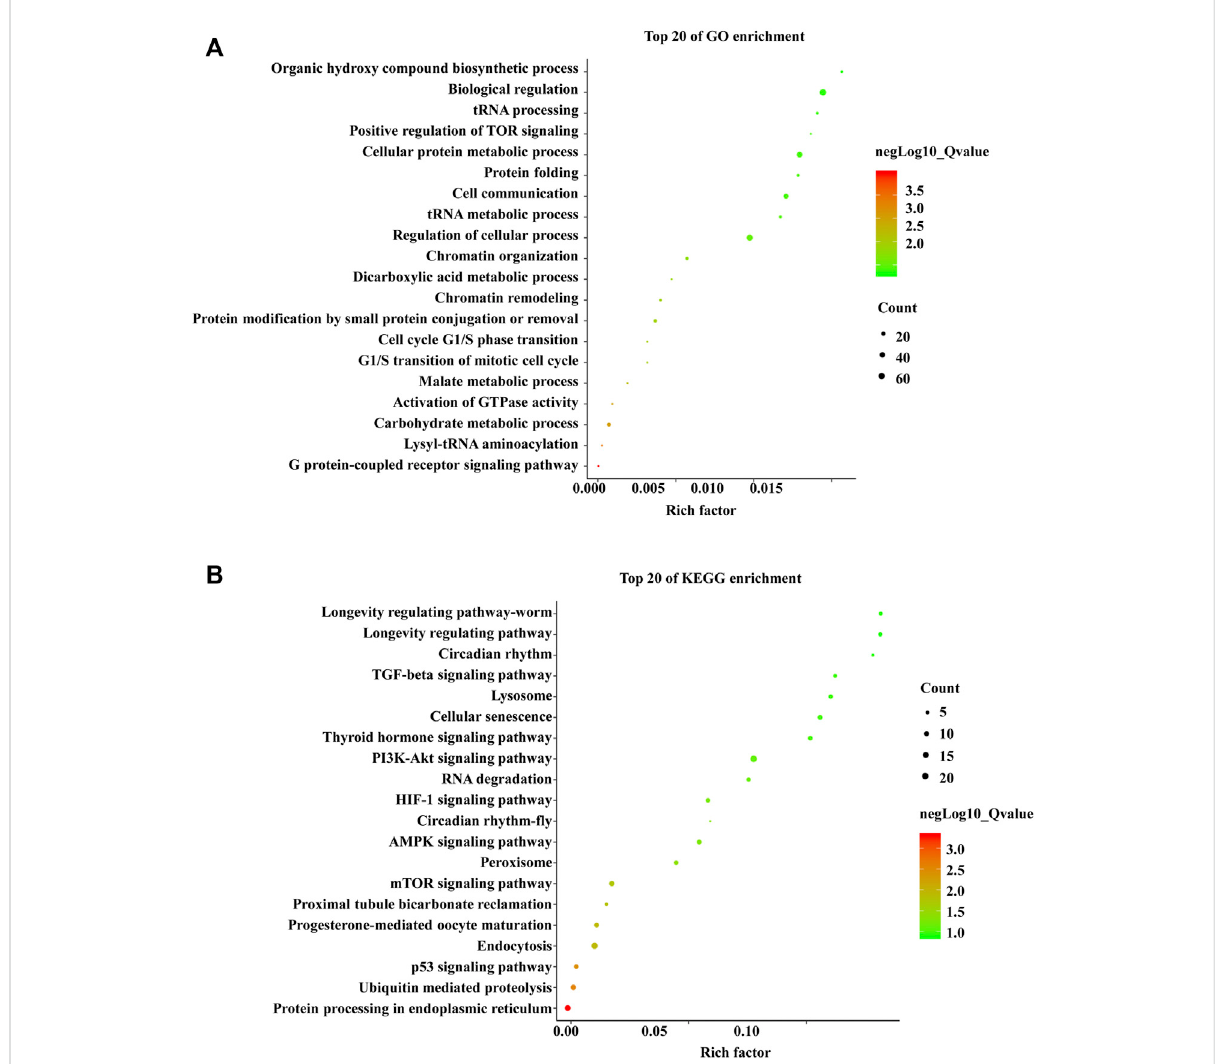
FIGURE 4 Gene Ontology (GO) and Kyoto Encyclopedia of Genes and Genomes (KEGG) enrichment analyses of the DE-miRNAs in the gonads of Collichthyslucidus . (A) GOenrichmentanalysisoftheDE-mRNAstargetedbyDE-miRNAs.The Y -axisrepresentsGOtermsandthe X -axisrepresents therichfactor.ThedotsizerepresentsthenumberofDE-mRNAsenrichedintheGOterms,andthecolorrepresentsthesigni fi canceoftheGOterm. (B) KEGGenrichmentanalysisoftheDE-mRNAstargetedbyDE-miRNAs.The fi gureshowsthe20mostenrichedpathwaysbetweentheovaries and testes. The Y -axis represents pathways and the X -axis represents the rich factor. The dot size represents the number of DE-mRNAs enriched in the pathway, and the color represents the signi fi cance of the